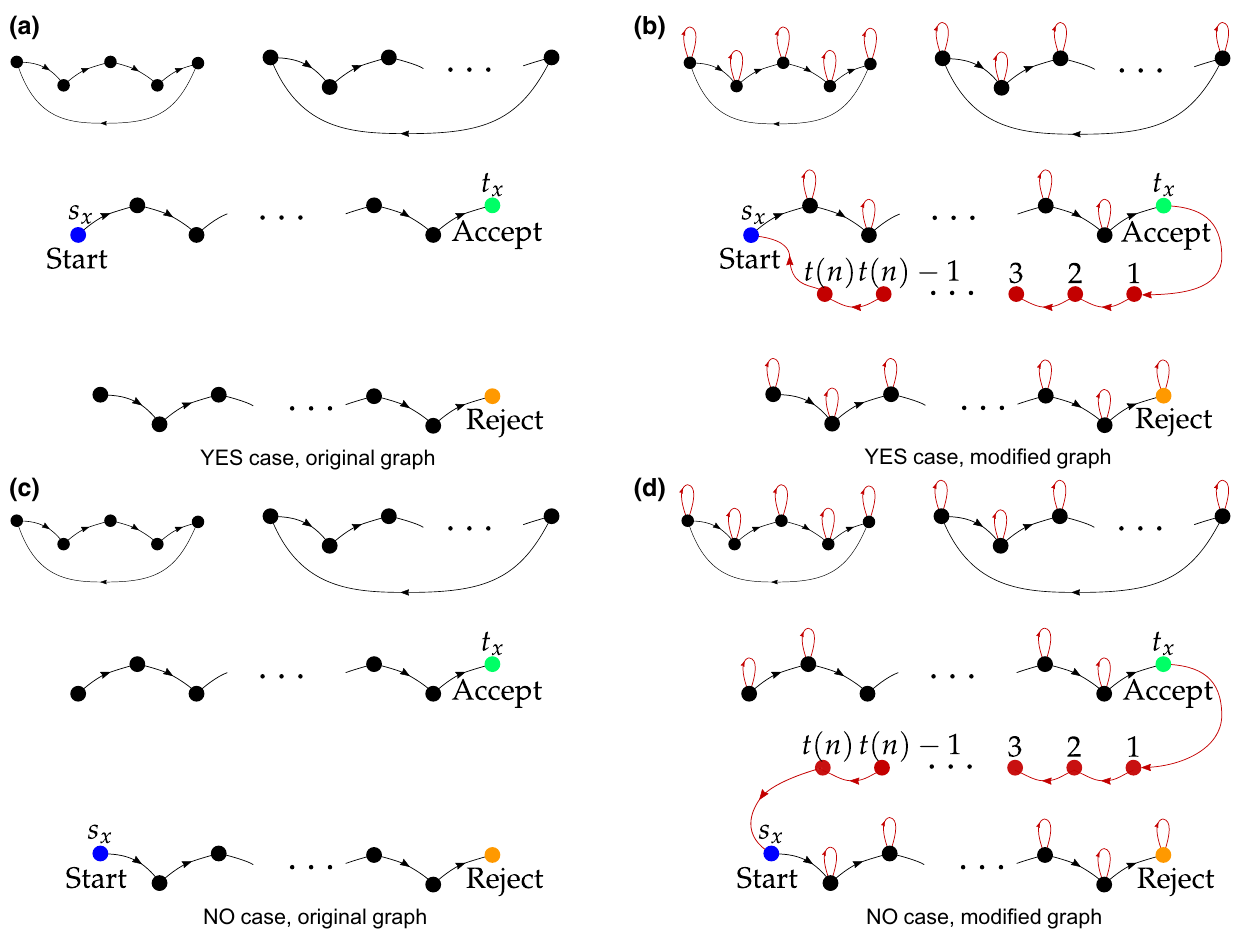
FIG. 2. Schematic of the original and modified graphs for both YES and NO cases. The original graph in both YES and NO cases consists of vertices with in degree and out degree at most 1, due to the fact that the Turing machine is reversible. The start vertex s x is marked in blue, the accept vertex t x in green, and the reject vertex in orange. The modified graphs have self-loops on all vertices except the start and the accept vertices. They have additional vertices 1, 2, . . . , t ( n ) without self-loops. All modifications are in maroon. (a) YES case, original graph. (b) YES case, modified graph. (c) NO case, original graph. (d) NO case, modified